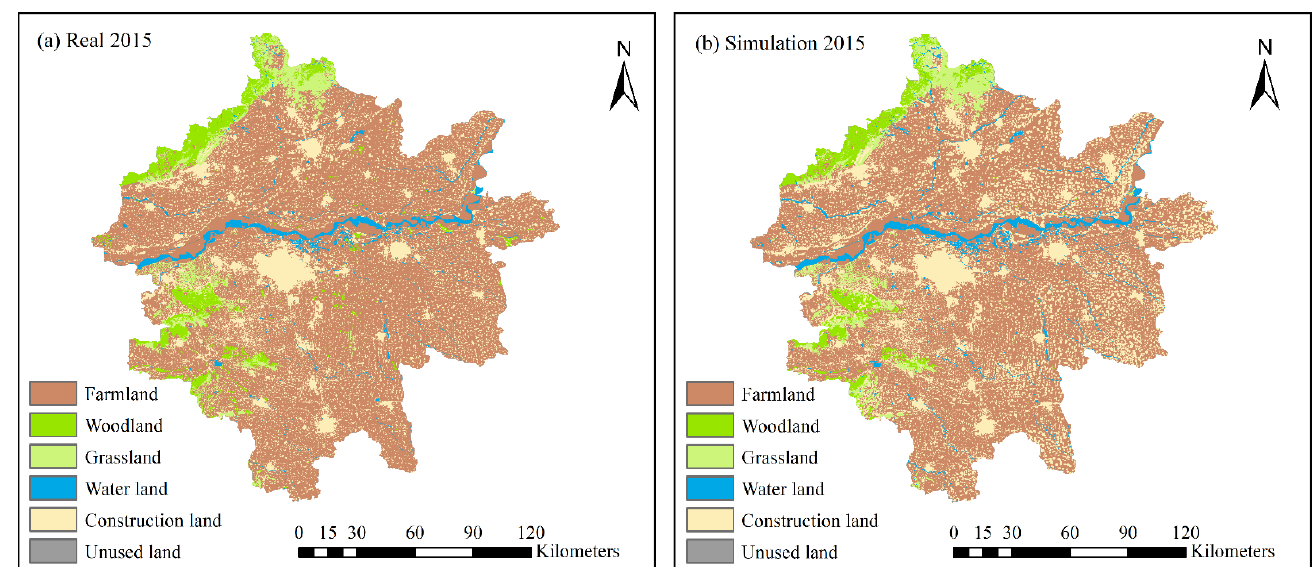
Figure 12. Comparison of land use from the ( a ) real and ( b ) simulated data in 2015. Table 5. Land use simulation accuracy evaluation for 2015 (unit: km²).